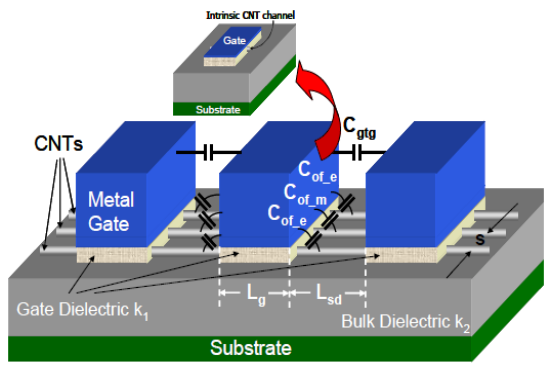
Figure 1. Layout of the CNFET device.